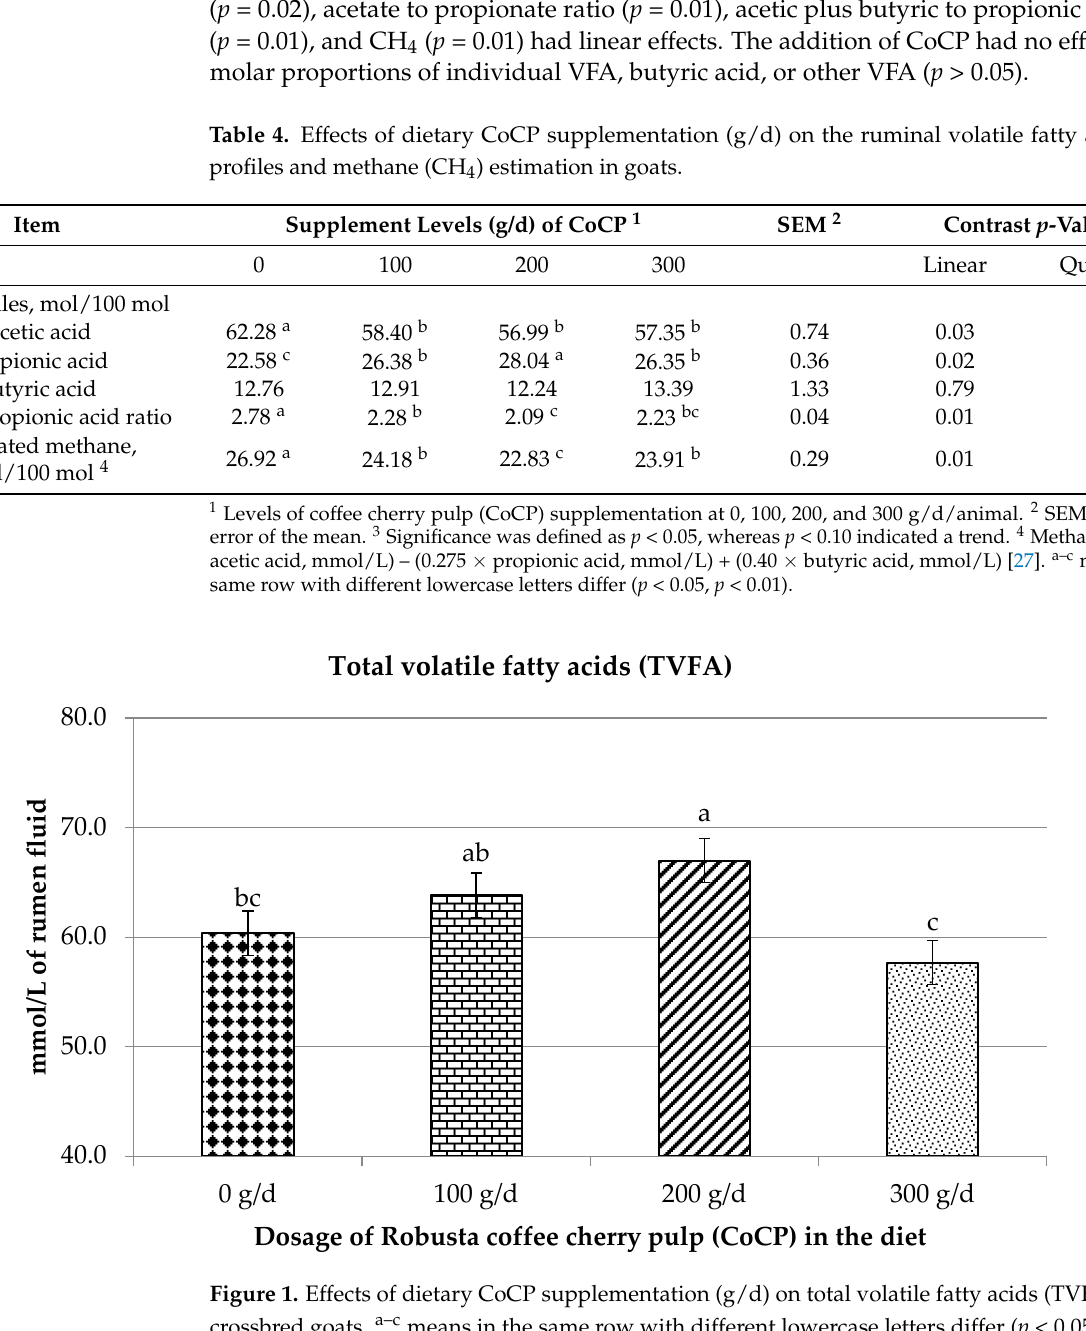
Table 5. Effects of dietary CoCP supplementation ( g / d ) on the microorganism count in the rumen.